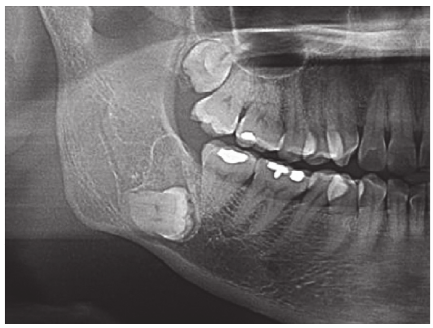
Figure 2: Mandibular odontogenic myxoma in a 44-year-old woman (Patient 9). Cropped panoramic image shows well-defined corticated, unilocular radiolucency associated with unerupted mandibular right third molar.